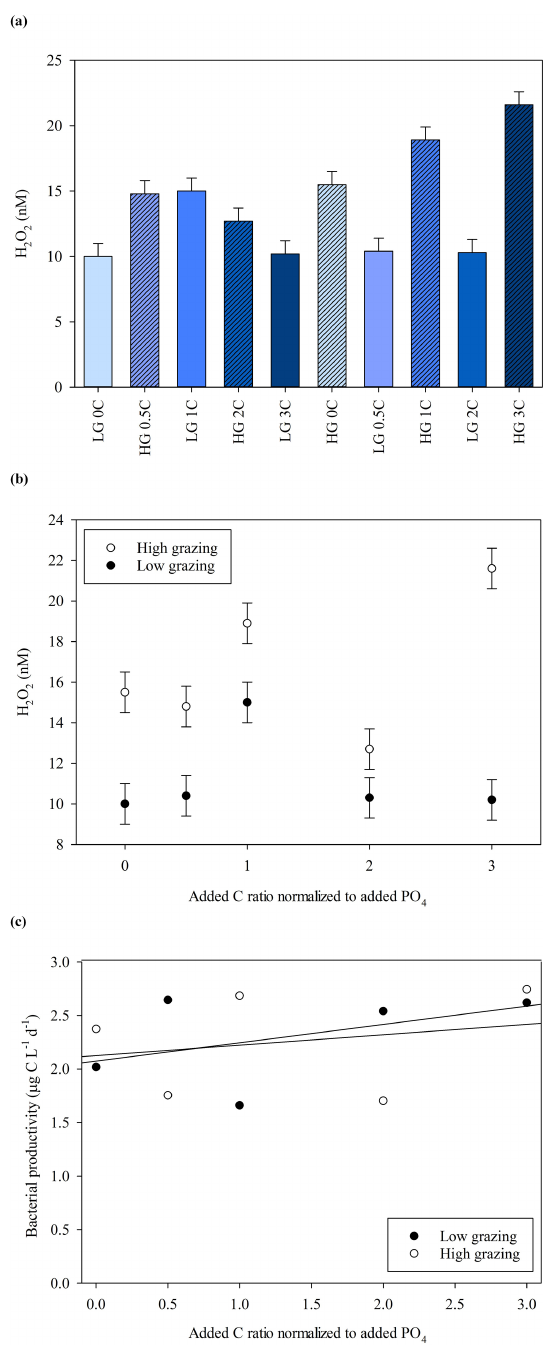
Figure 6. (a) H 2 O 2 concentrations at the end of the MicroPat ex- periment. High-grazing treatments are hashed; DOC added at 0, 0.5, 1.0, 2.0 and 3.0 times the Redfield carbon (C):phosphate ratio in- dicated by increasing colour density. (b) No clear trend was evident across the DOC gradient, but high grazing was consistently asso- ciated with higher H 2 O 2 concentration. (c) Bacterial productivity in the same experiment. Error bars show ± SD of at least triplicate